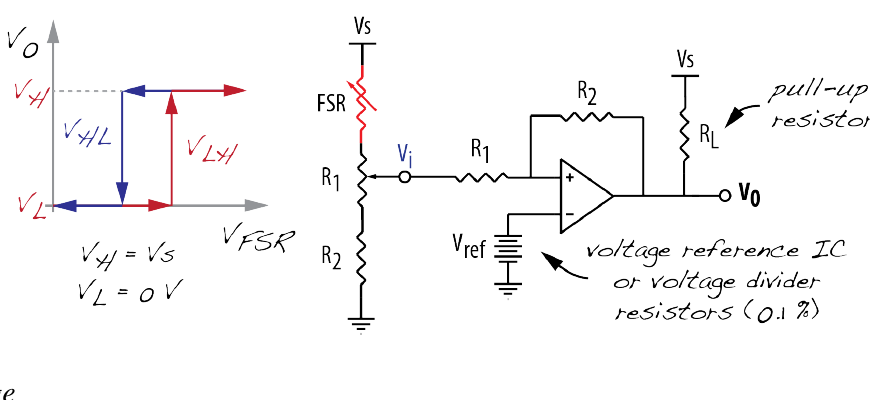
Figure 10. Comparator with